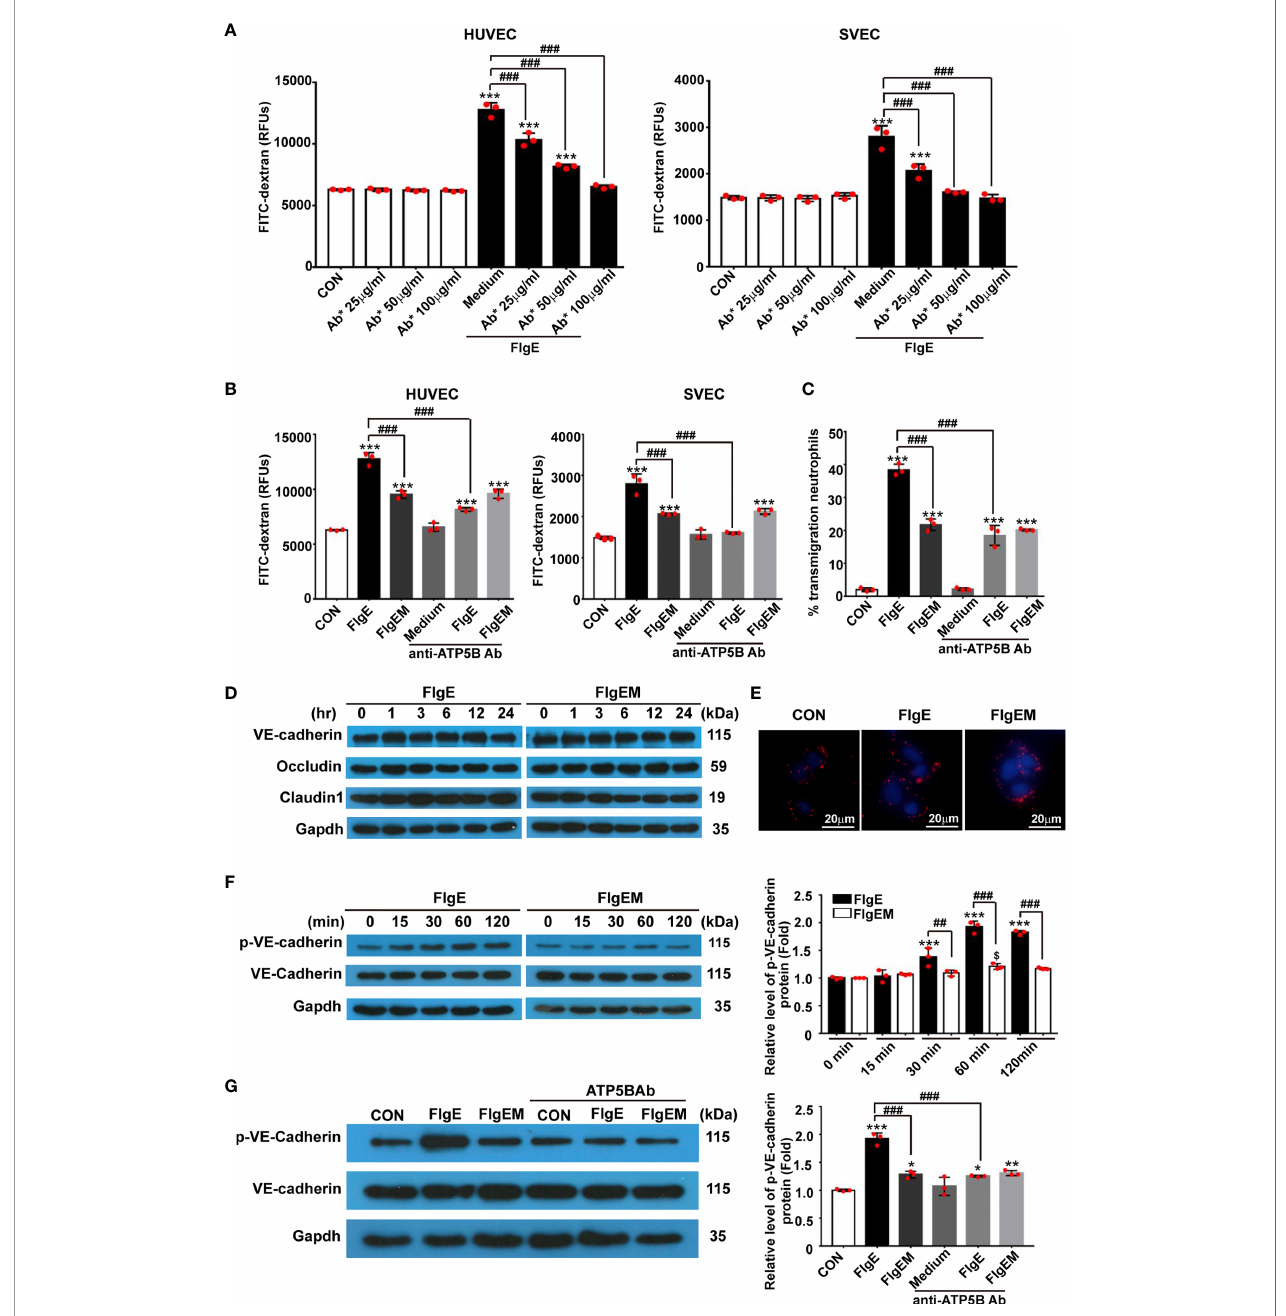
FIGURE 6 | FlgE-induced hyperpermeability in EC monolayers was inhibited by anti-ATP5B antibodies and involved VE-cadherin phosphorylation. (A – C) Endothelial cells were cultured on collagen-coated fi lters for 24 h and then incubated with different concentrations of anti-ATP5B antibodies (25, 50, and 100 m g/ml) for 1 h followed by addition of FlgE or FlgEM (20 m g/ml). After 24 h, FITC-dextran (40 kDa) was added into the upper chamber (0.5 mg/ml) for 2 h, and the fl uorescence in the lower chamber was measured in a fl uorimeter (A, B) , or neutrophils isolated from human peripheral blood were added into the upper chambers and incubated for 1 h at 37°C, and the percentage of transmigrated neutrophils in the lower chambers was calculated (C) . (D, F, G) HUVECs, with or without 1-h pretreatment with anti-ATP5B antibodies (50 m g/ml), were treated with FlgE or FlgEM (20 m g/ml) for desired time length; and total proteins were subjected to blotting for VE-cadherin, Tyr731-phosphorylated VE-cadherin, occludin, or claudin-1, with GAPDH as reference. Resulting bands were analyzed with ImageJ software. (E) HUVECs were treated with FlgE or FlgEM (20 m g/ml) for 24 h, and the distribution of VE-cadherin is shown using confocal microscopy (VE-cadherin, red; DAPI, blue). Scale bars, 20 m m. Shown is one of the three repeats with similar results. * p < 0.05, ** p < 0.01, *** p < 0.001, vs. CON. ## p < 0.01, ### p < 0.001 vs. FlgE by one-way (A – C, G) or two-way ANOVA (F) test. Mean ± SD was obtained from three duplicates in each experiment. HUVECs, human umbilical vein endothelial cells; EC, endothelial cell; FITC, fl uorescein